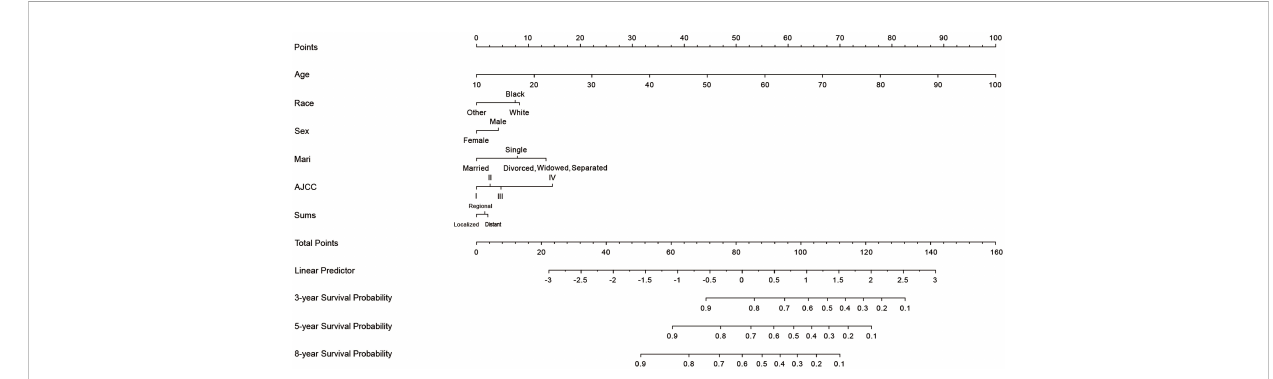
FIGURE 2 Nomogram for predicting 3-, 5-, and 8-years cutaneous verrucous carcinoma overall survival of probability. The value of each of variable was given a score on the point scale axis. A total score could be easily calculated by adding each single score and, by projecting the total score to the lower total point scale, we were able to estimate the probability of CVC. Sums, combined summary of stage; Mari, marital status; AJCC, American Joint Committee on